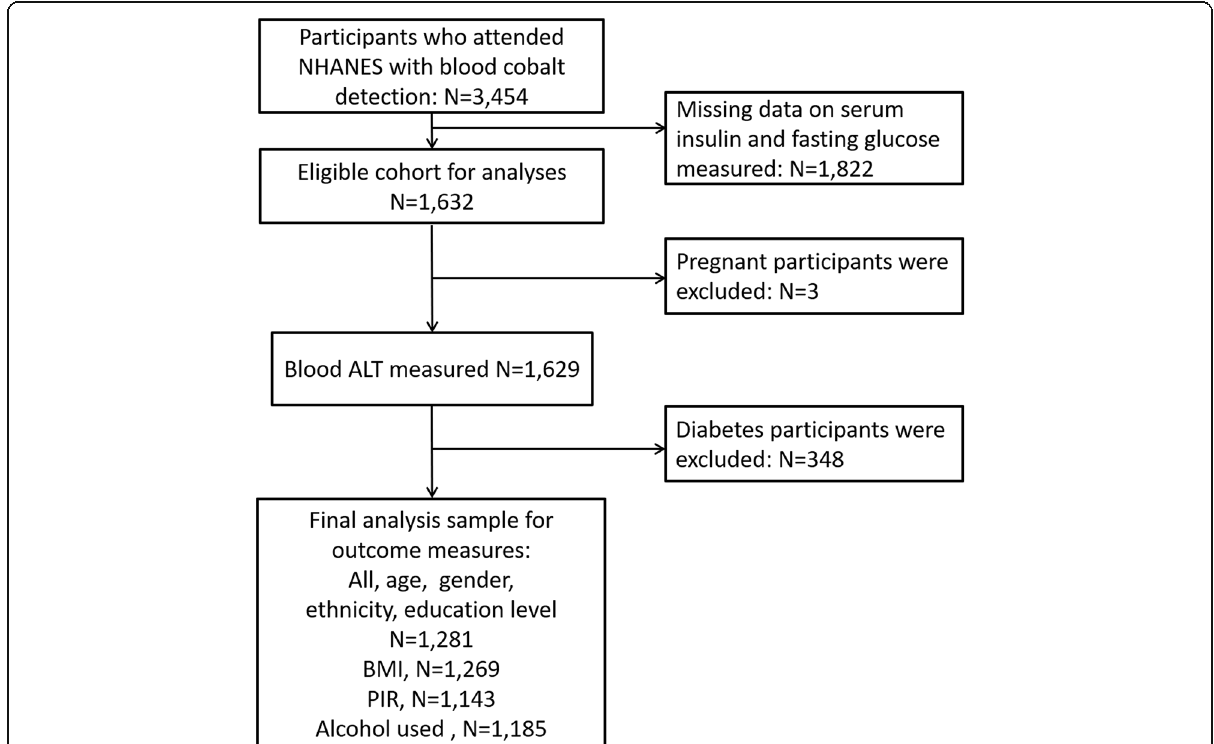
Fig. 1 Eligible participants and those included in the analyses of the associations between blood cobalt exposure and insulin resistance in